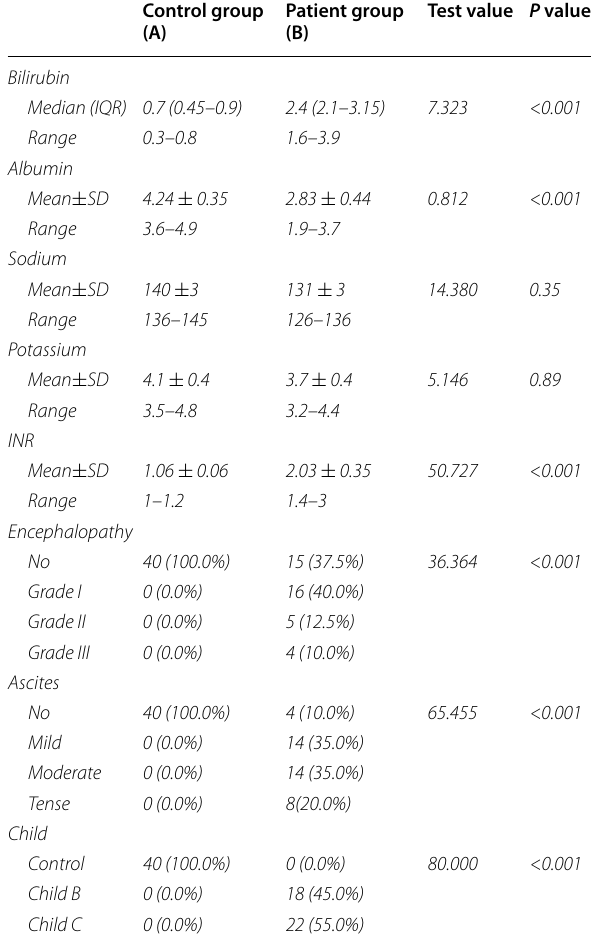
Table 2 Laboratory and clinical parameters in patients and